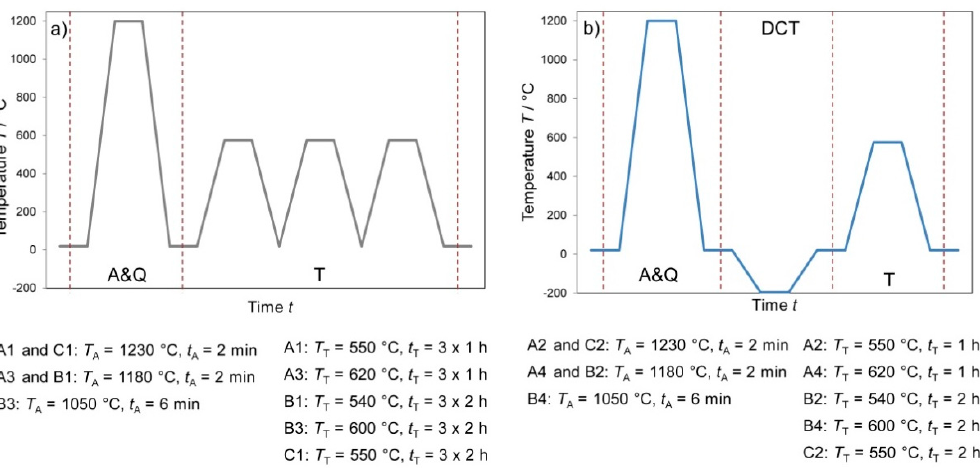
Figure 1. Parameters and schematic presentation of the conventional heat treatment procedure ( a ) and of the conventional heat treatment procedures with deep cryogenic treatment ( b ).